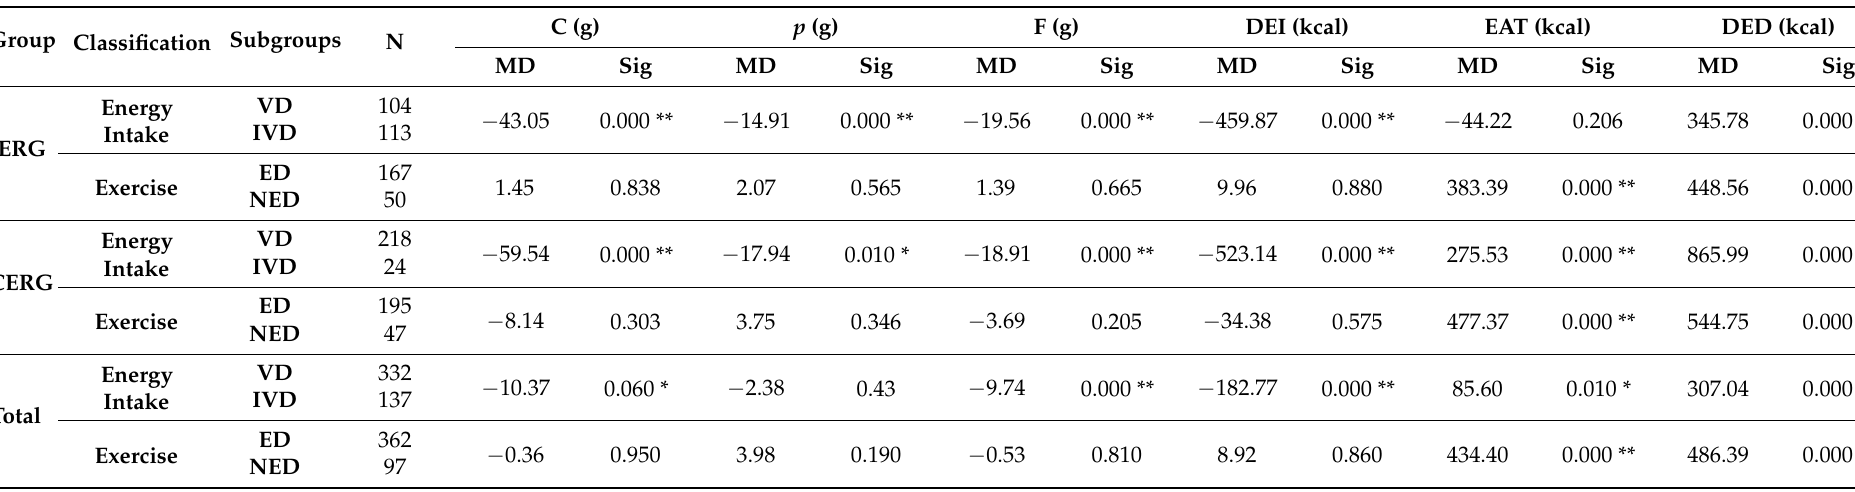
Table 6. Comparison between the mean value of daily statistics between valid and invalid